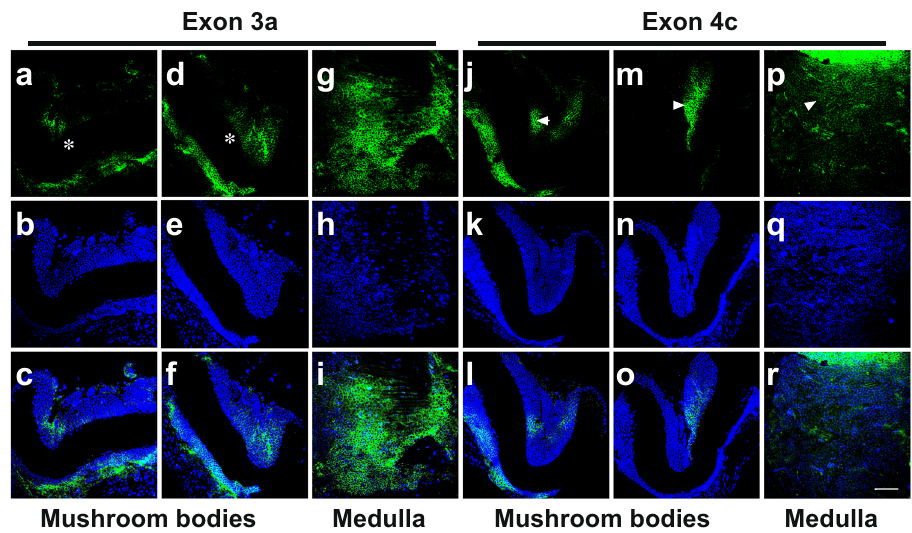
Fig. 4 Alternative splicing of elavl2 exons 3a and 4c is dynamic in mushroom bodies. Representative RNA in situ hybridizations in worker bees against elavl2 exon 3a ( a , d, and g ) and exon 4c ( j , m, and p ) in mushroom bodies ( a , d , j, and m ) and the medulla ( g and p ) counterstained with DAPI to visualize nuclei ( b , e , h , k , n, and q ) and merged pictures ( c , f , i , l , o, and r ). Scale bar in R is 30 µ m.